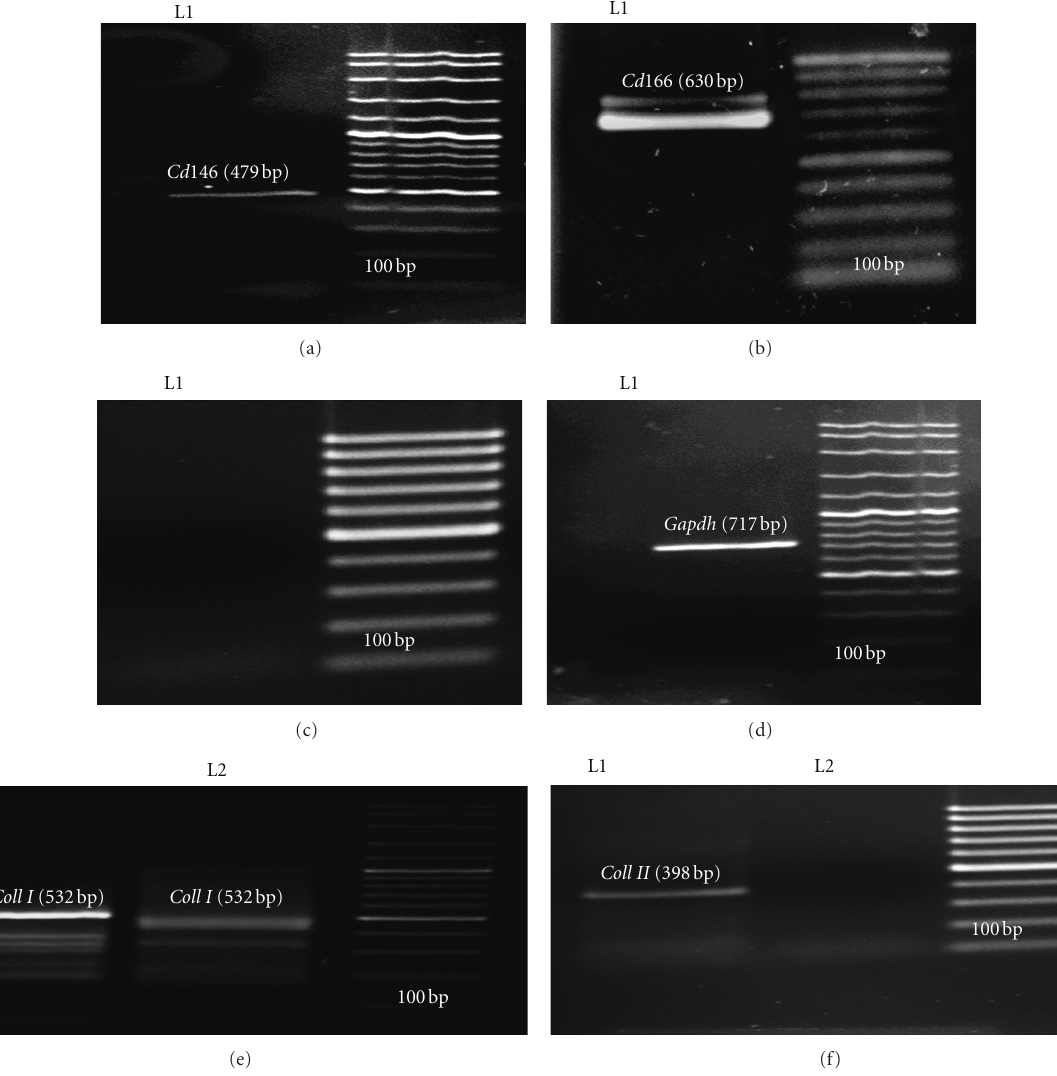
Figure 3: RT-PCR analyses of mouse DPSC in 1% (w/v) Agarose. (a) Cd146 (479bp), (b) Cd166 (630bp), (c) Cd 31 (355 bp), (d) Gapdh as a house keeping gene (717bp). (e, L1) The Coll I marker (532bp) was after 14 days induction and (e, L2) before induction. (f, L1) Coll II after 21 days induction and (f, L2) before